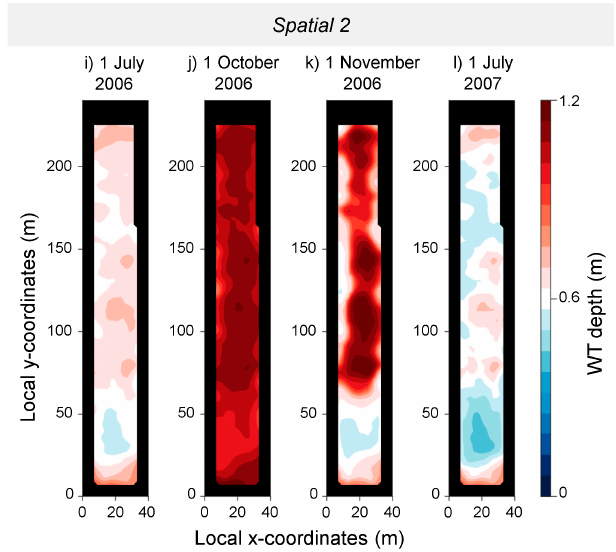
Figure 6. Water table (WT) depth at different dates (1 July 2006; 1 October 2006; 1 November 2006; 1